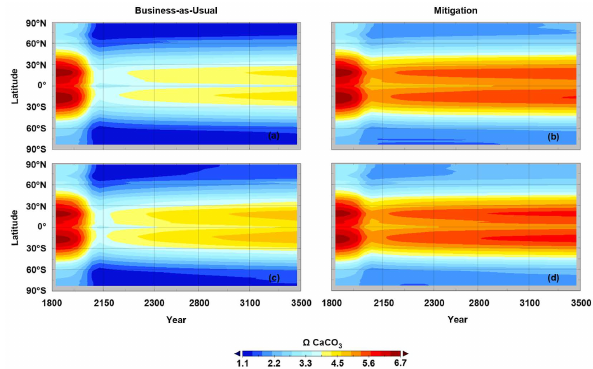
Fig. 6. Evolution of sea surface calcite saturation state over time as a function of latitude for (a) run S0, (b) run M0, (c) run S5, and (d) run M5 respectively.